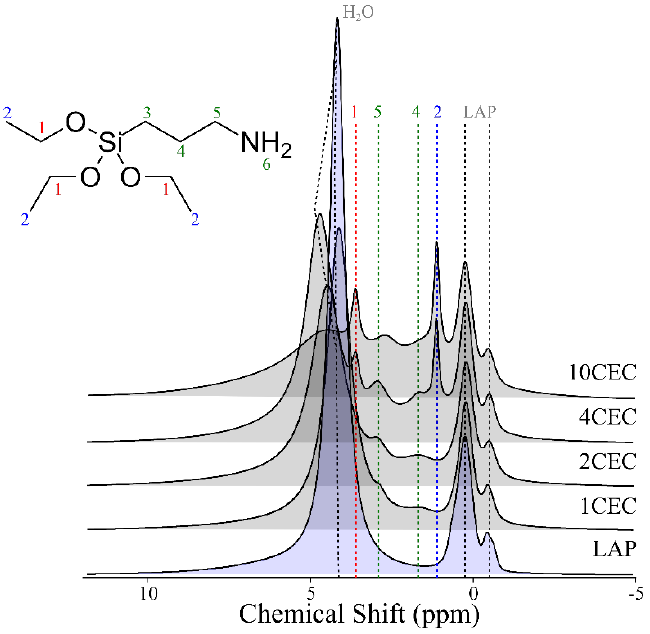
Figure 4. Solid-state 1 H NMR spectra of LAP and LAP-APTES for different loads of APTES.